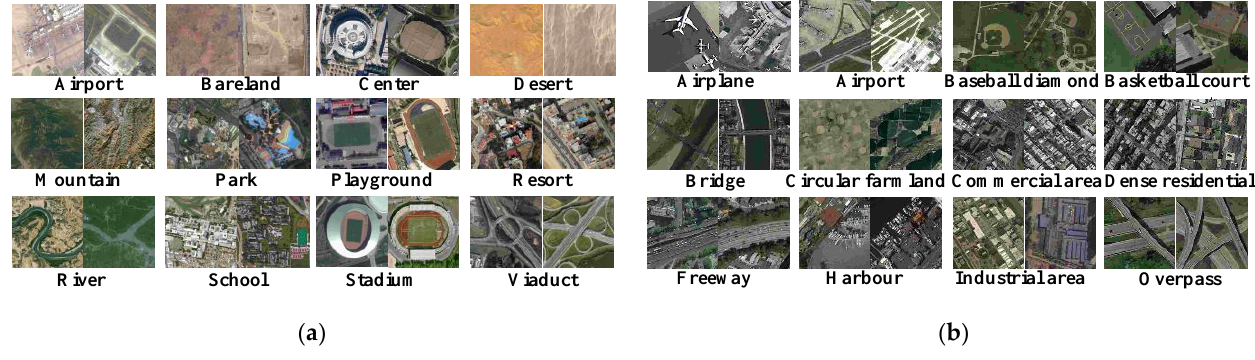
Figure 5. Example images of the datasets: ( a ) AID and ( b ) NR.